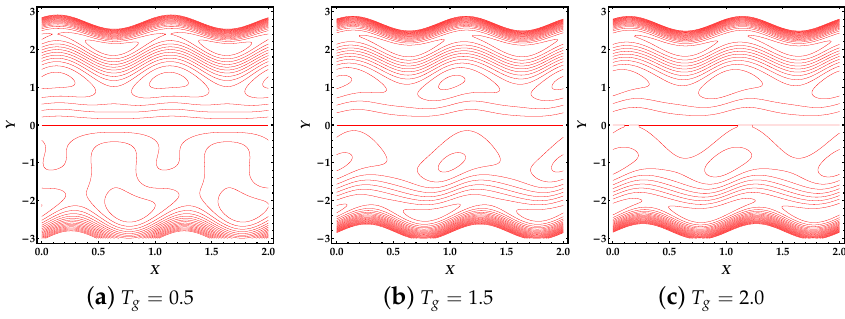
Figure 5. Streamline patterns against multiple values of Ha .